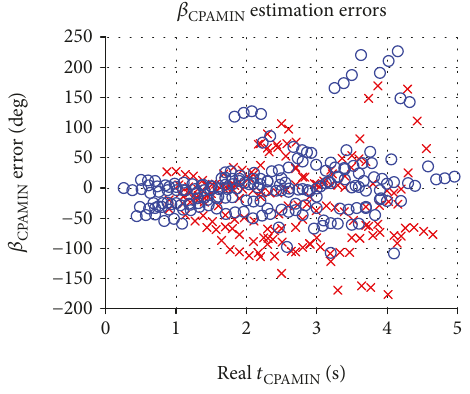
Figure 17: Estimation errors of the direction of CPA (red x: close encounters; blue circle: far encounters).